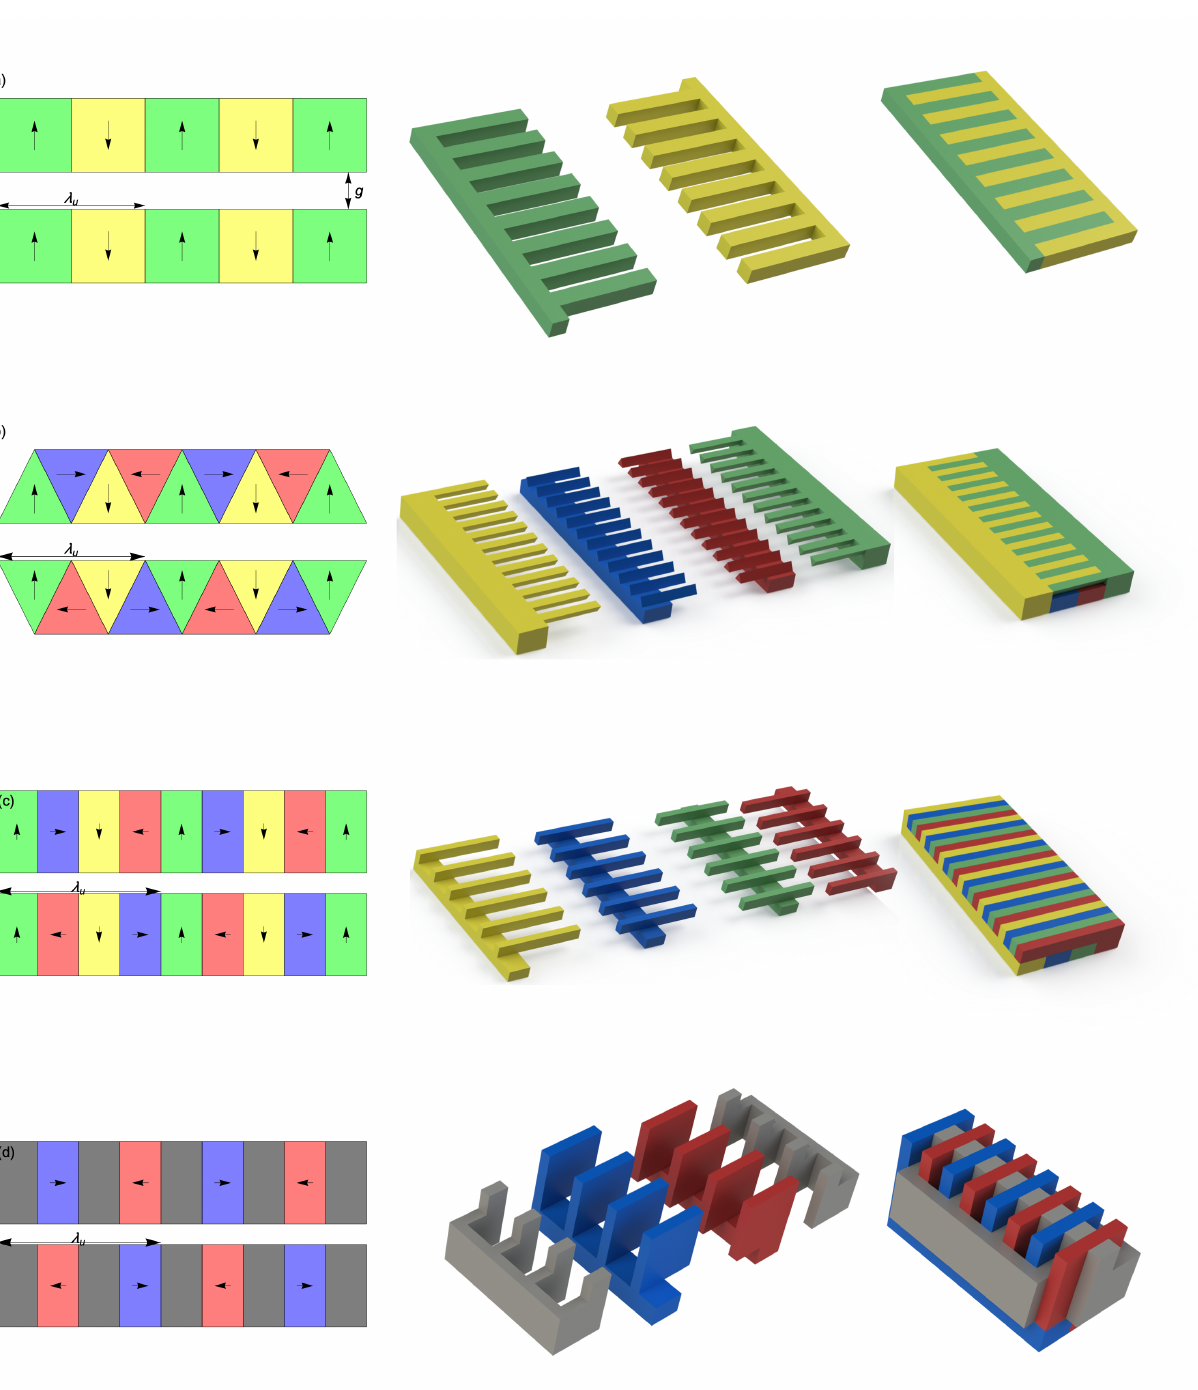
Figure 1. Examples of the simulated undulator configurations. The left column shows an idealized, 2D cross section omitting connecting parts. The center column shows the constituent parts of the lower jaw in a preassembly state. The right column shows the assembled state of the lower jaw array. By row: ( a ) M (cid:48) = 2 array, ( b ) isosceles triangle array, ( c ) M (cid:48) = 4 array, and ( d ) hybrid array. Green and yellow correspond to vertical magnetization vectors, blue and red correspond to longitudinal magnetization vectors, and gray corresponds to a high-saturation, soft ferromagnetic